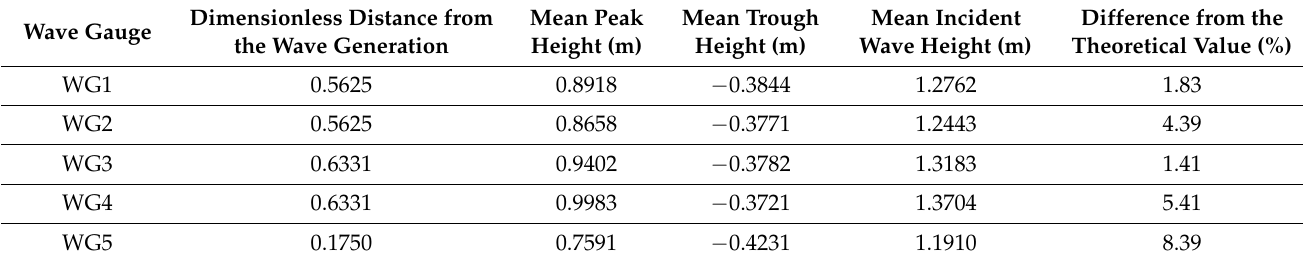
WG1 and WG2 were located at a dimensionless distance 0.5625 from the wave gen- Table 8. Wave-generation capabilities at different wave gauges in the Numerical Wave Tank (NWT). eration. Conversely, the y -direction of WG1 was near the wall, whereas that of WG2 was Dimensionless Distance at the centre of the NWT. The agreement between the two wave gauges was very good Wave Gauge based on the difference from the theoretical values varying between 1.83% to 4.39%. In addition to the above-mentioned data, WG3 and WG4 were located at a dimensionless